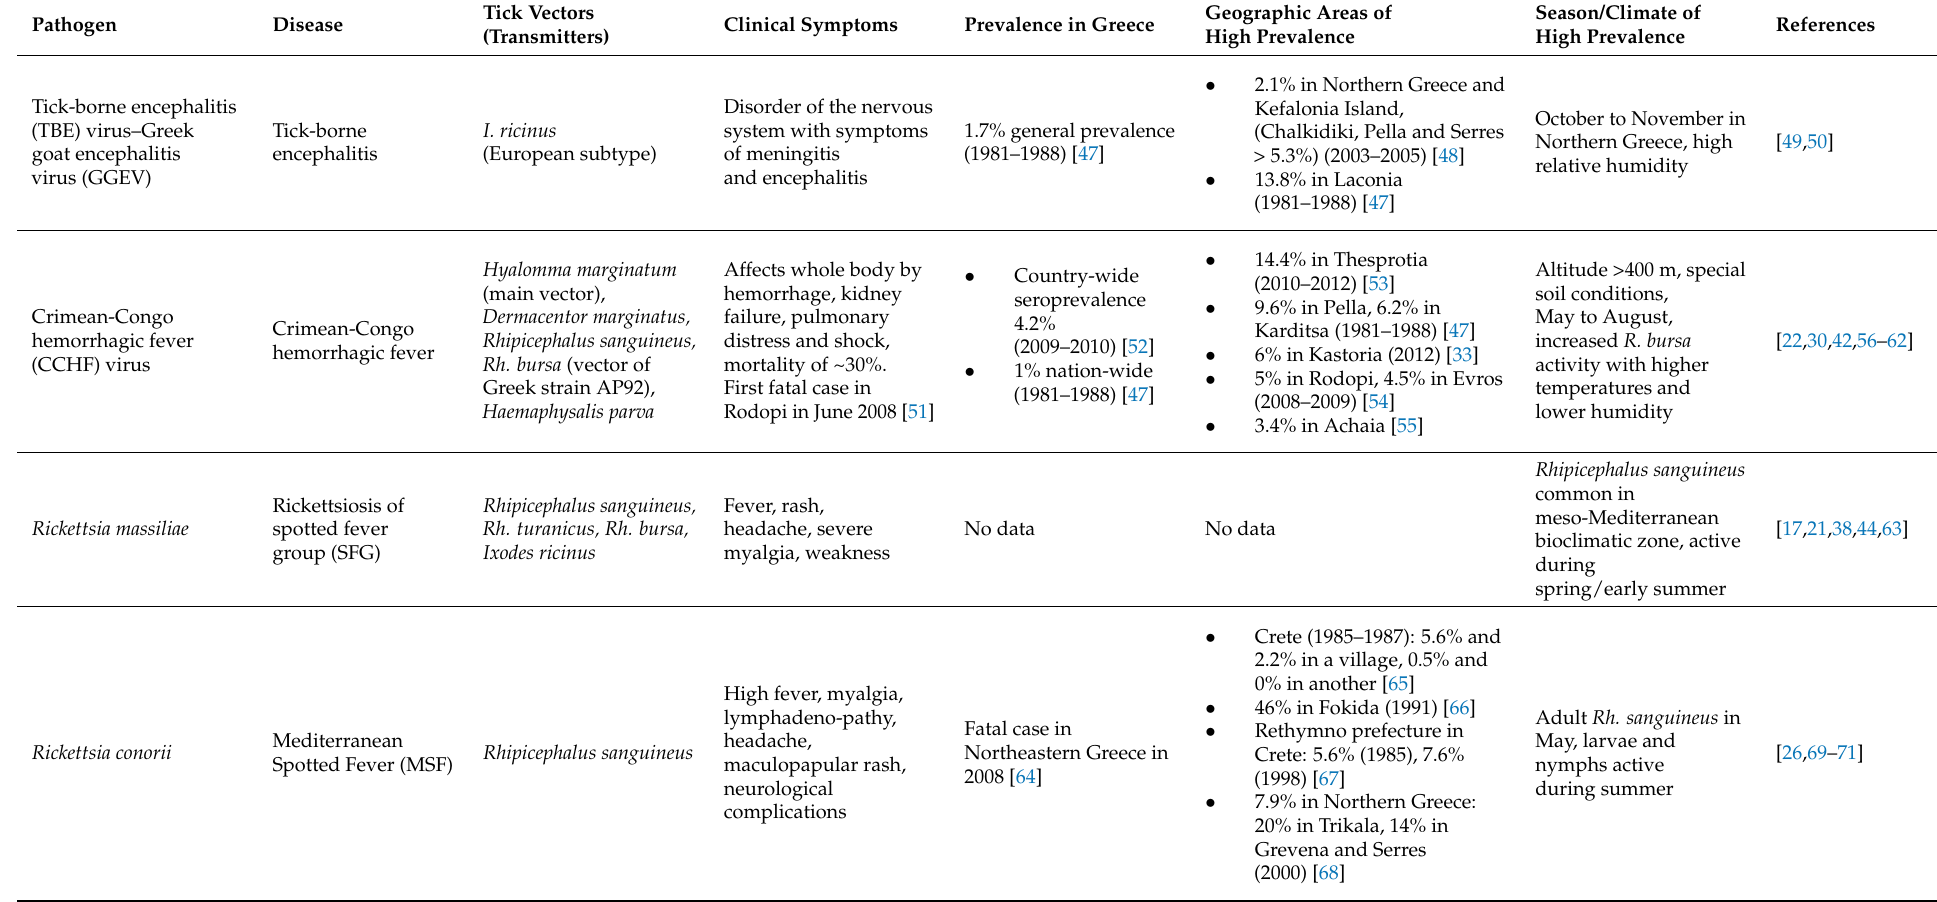
Table 3. Important tick-borne pathogens, associated human and domestic animal diseases, and their prevalence in